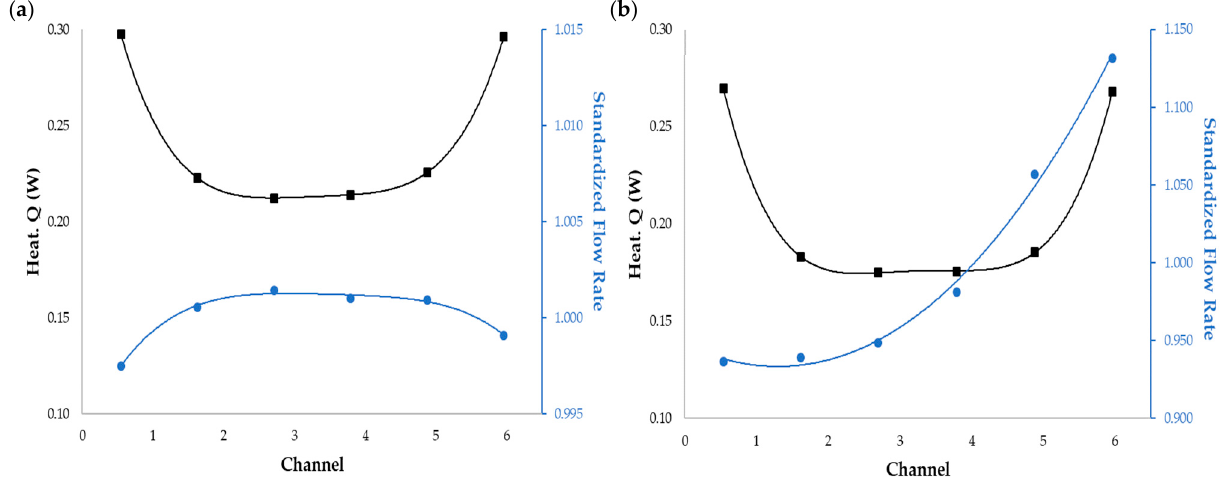
Figure 23. Heat transfer rate in each channel of the geometries: ( a ) Vertical rectangular. ( b ) Horizontal parallel.